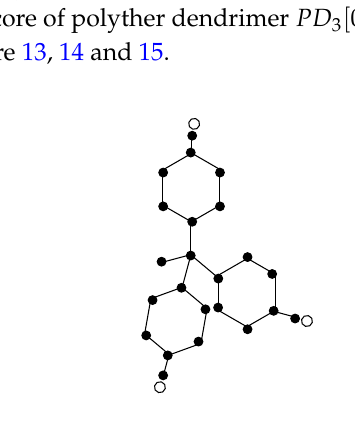
Figure 13. The core of polyther dendrimer PD 3 [ 0 ]